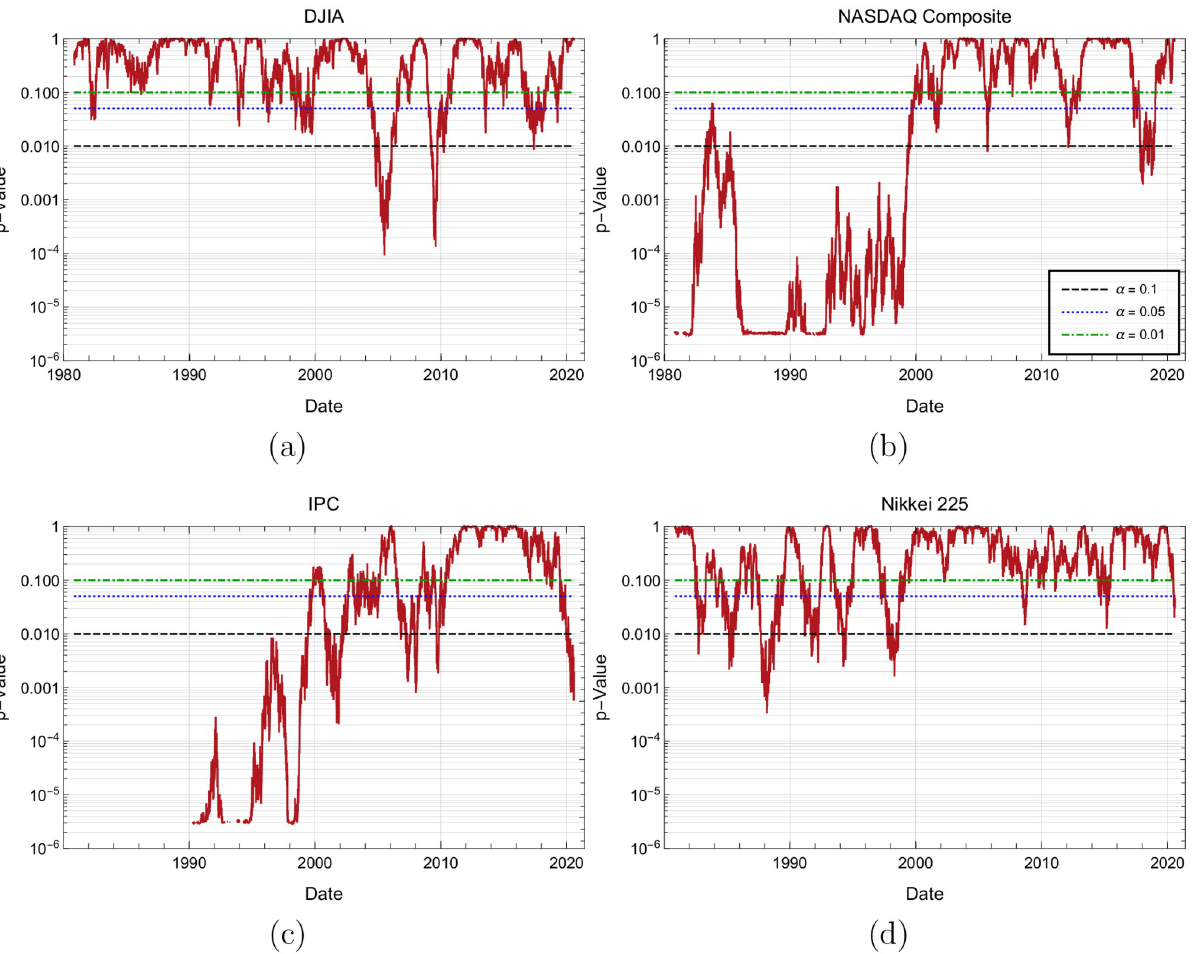
Fig 7. Subfigures 7(a) to 7(d) all show the p -values of the Anderson-Darling statistic evolution on time for DJIA, Nasdaq, IPC and Nikkei indices,